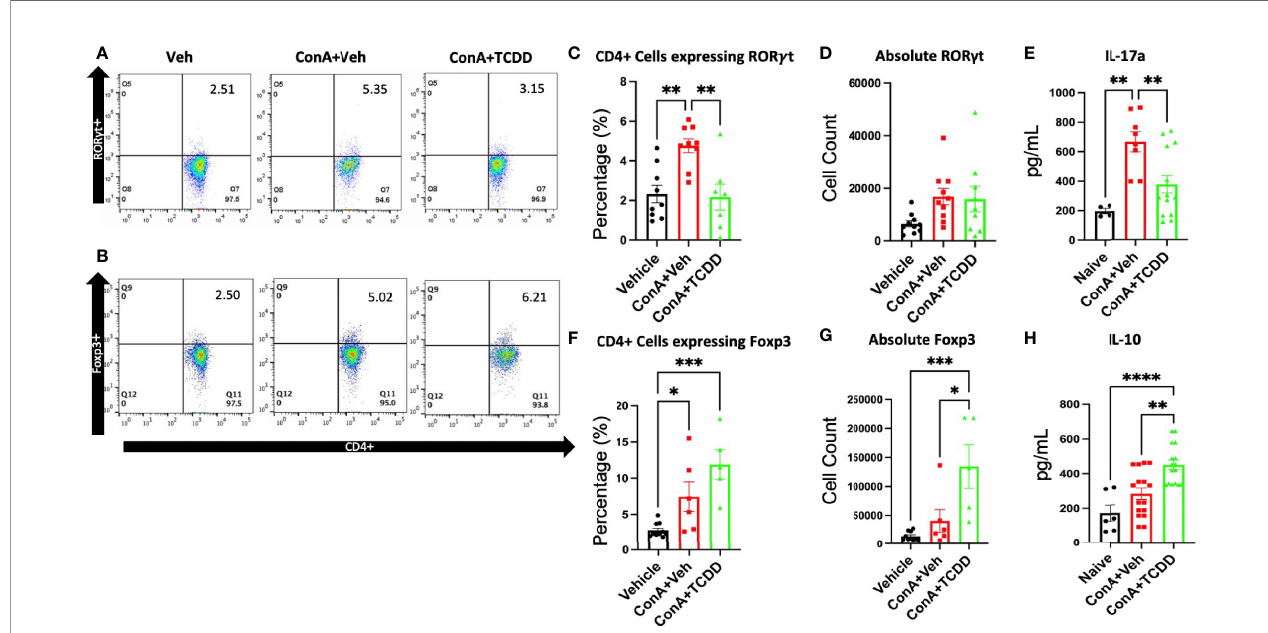
FIGURE 2 | TCDD treatment alters the ratio of Th17/Treg cells in the liver. C57/BL6 mice were injected with ConA followed by vehicle or TCDD 1 hour later as described in Figure 1 legend. After 24 hours, liver mononuclear cells were harvested and stained for Th17 (CD4+ROR g t+) and Treg cells (CD4+Foxp3+). (A, B) Representative fl ow plots showing cells double-stained for the markers. (C) Percentage of Th17 cells. (D) The absolute number of Th17 cells found per animal. (E) Measurement of IL-17A by ELISA in cell cultures. (F) Percentage of cells expressing CD4+FoxP3+. (G) Total number of cells expressing Foxp3/per mouse. (H) Measurement of IL-10 in cultures. (n = 5-10 mice) Signi fi cance was determined by one-way ANOVA followed by Tukey ’ s post-hoc test. Vertical bars represent Mean +/- SEM. *p < 0.05, **p < 0.01, ***p < 0.001, ****p <